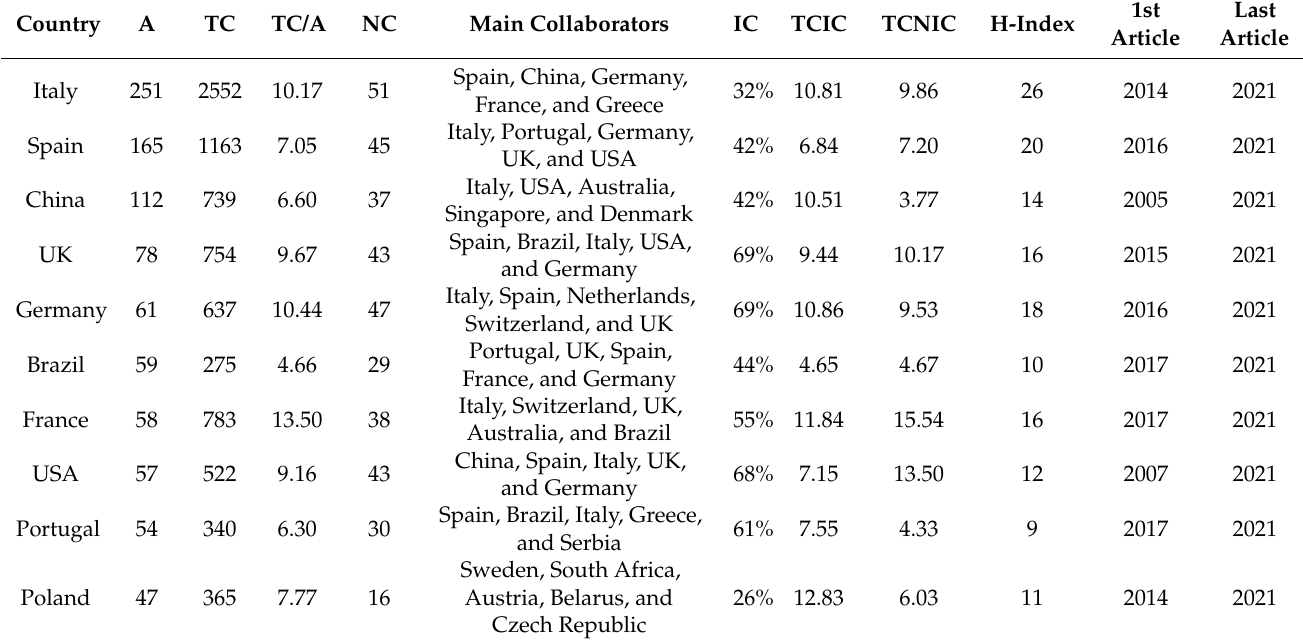
Table 5. The most relevant countries and their international collaboration